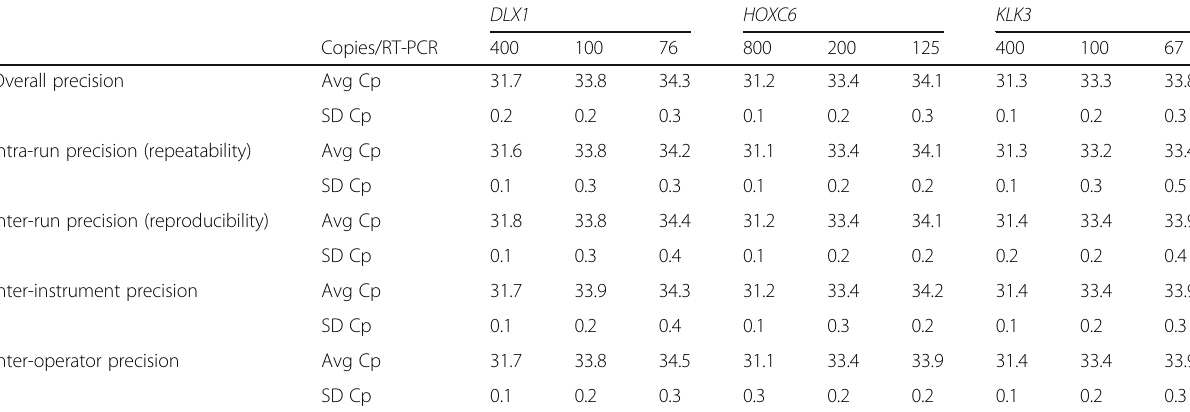
Table 5 Precision of DLX1 , HOXC6 , and KLK3 mRNA-based assays